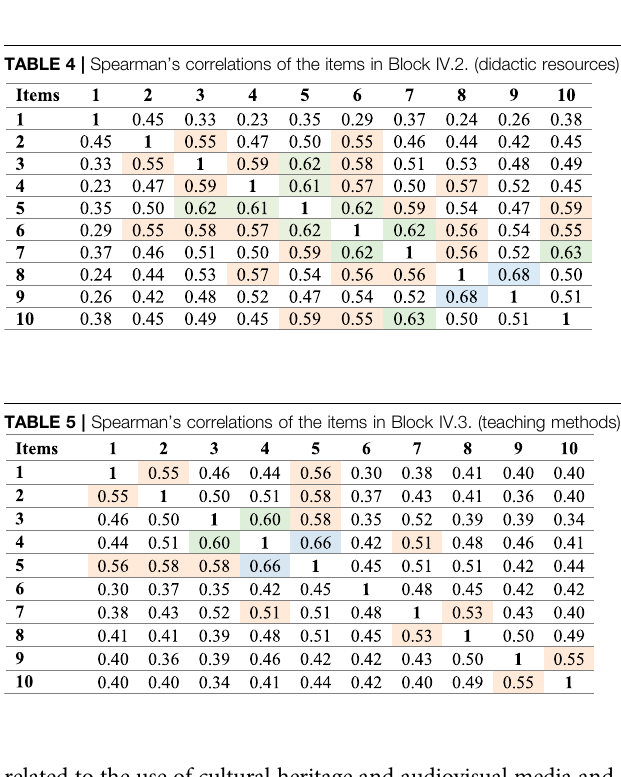
FIGURE 2 | Descriptive of the didactic methods. Block IV.3. of the